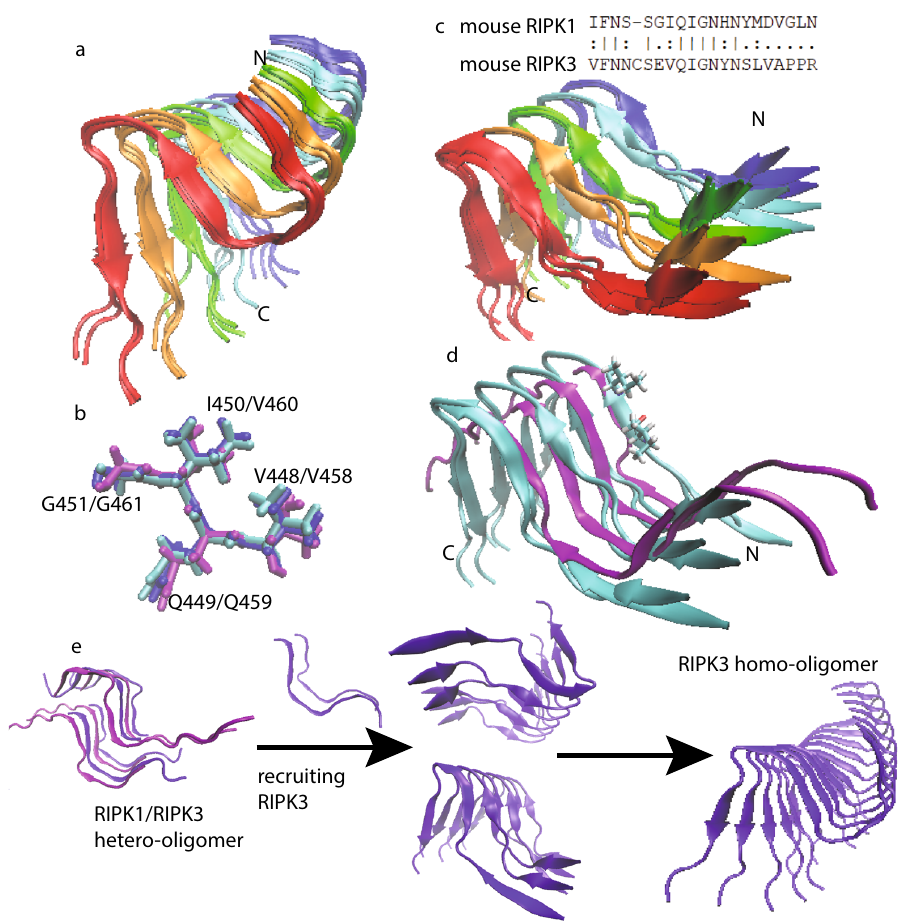
Fig. 8 Molecular dynamics (MD) simulations using Xplor-NIH on mouse RIPK3 fi brils and a hetero-amyloid model of mouse RIPK1/RIPK3. a The best four structures of mouse RIPK3 fi bril after 50 ps MD, showing the fi bril developing a left-hand twist. b The structure alignment of RIPK3 conserved tetrad sequence from human RIPK1/RIPK3 hetero-amyloid structure (purple, 5v7z.pdb), mouse RIPK3 fi bril structure (blue, 6JPD.pdb) and mouse RIPK3 fi bril after 50 ps MD from ( a ) (cyan). c The best four structures of mouse RIPK1/RIPK3 hetero-amyloid after 50 ps MD run, showing the opening the β -arches formed by the 1st and 2nd β -strand. The mouse RIPK3 fi bril structure was adopted as the starting con fi guration for the MD. The sequence alignment for mouse RIPK1 and RIPK3 is shown on the top. d The structure comparison between c (cyan, showing only the best two structures for clarity, residue V448, I450 was also shown in one subunit) and RIPK1/RIPK3 from the human RIPK1/RIPK3 hetero-amyloid structure (purple, 5v7z.pdb). e The proposed mechanism showing RIPK3 structural transformation from initial RIPK1 – RIPK3 binding to RIPK3 fi bril